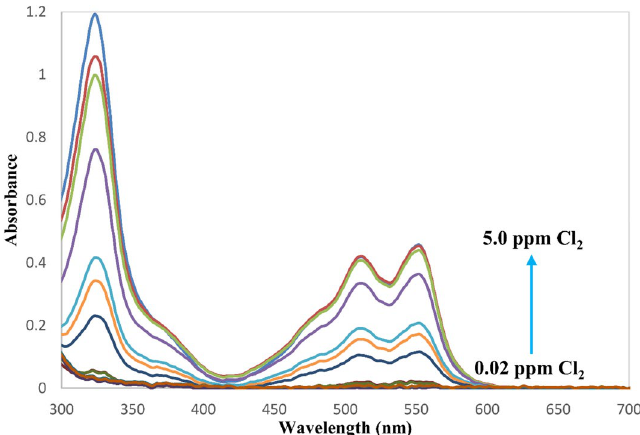
Figure 2. The calibration spectra obtained using the benchtop spectrophotometer for the determination of residual chlorine in water (conditions: 100 μL DPD reagent and 100 μL buffer solution of pH 6 were added to a total volume of 5.0 mL).